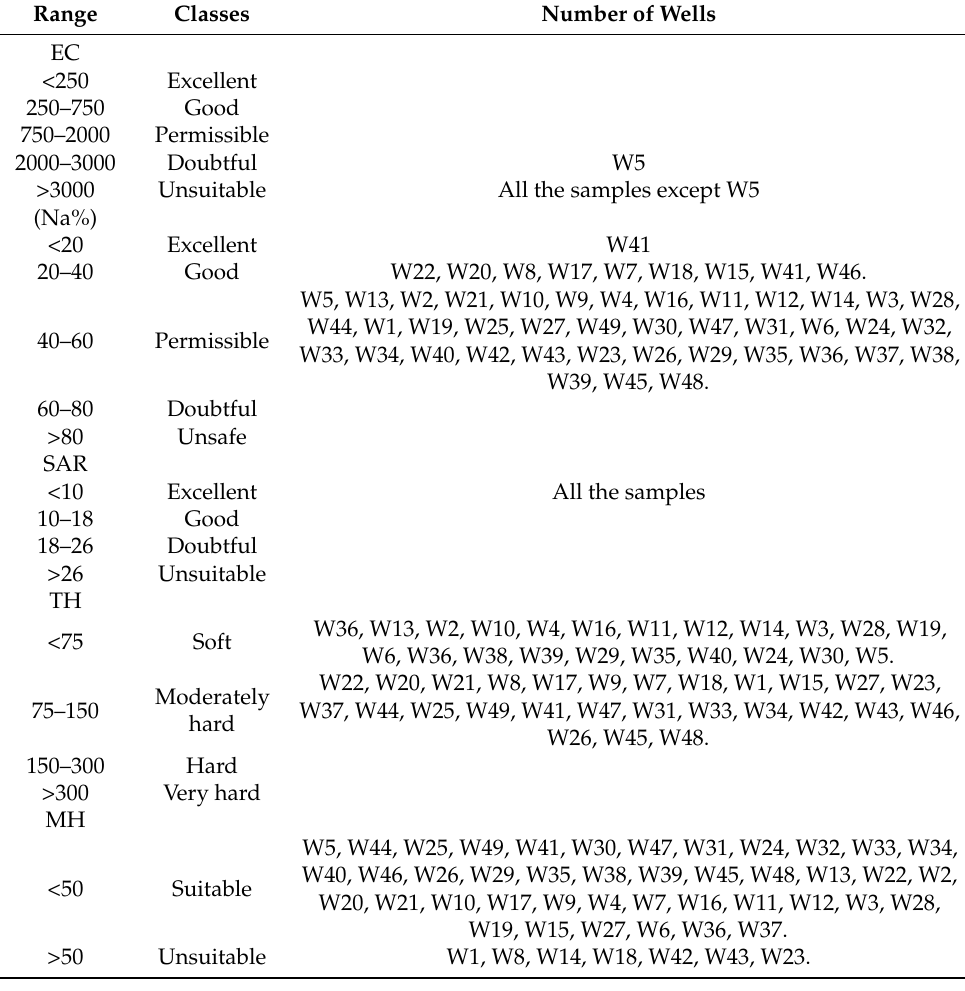
Table 4. Irrigation quality indices of the complex terminal